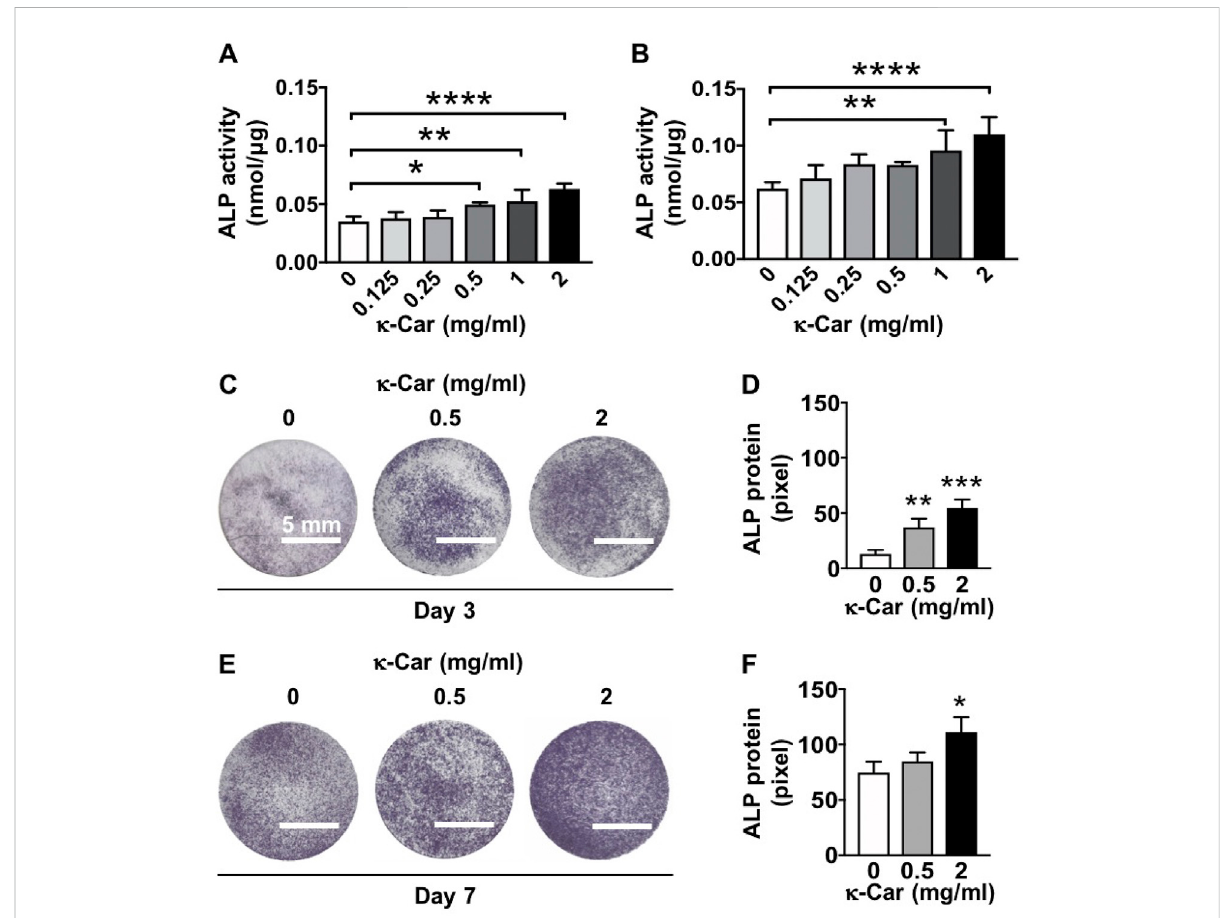
FIGURE 7 Dose-dependent effect of κ -carrageenan inOCP-coating of titanium discs on ALP activity of MC3T3-E1 pre-osteoblasts atday 3 and 7. (A) ALP activity at day 3. (B) ALP activity at day 7. (C) ALP protein staining at day 3. (D) Quantitive colorimetric results of ALP staining at day 3. (E) ALP